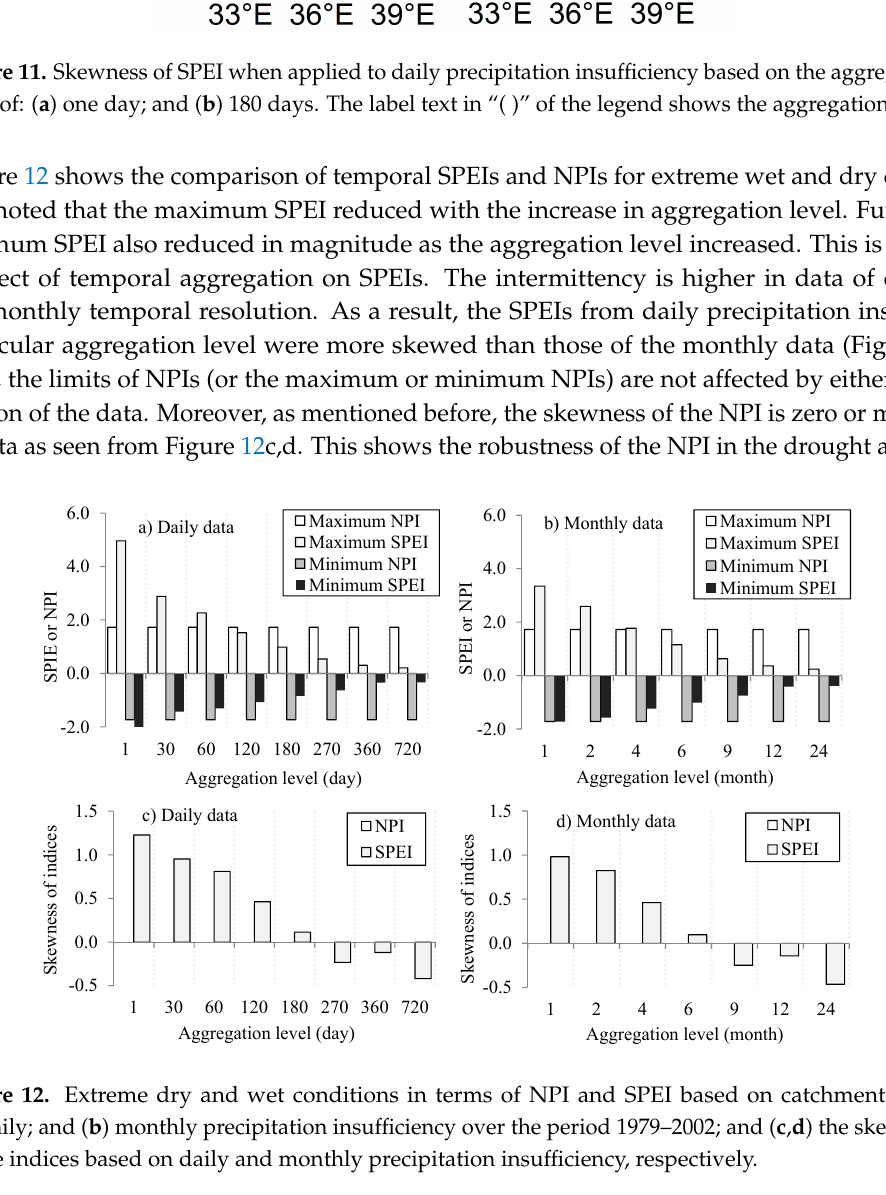
Figure 11. Skewness of SPEI when applied to daily precipitation insufficiency based on the aggregation level of: ( a ) one day; and ( b ) 180 days. The label text in “( )” of the legend shows the aggregation level.